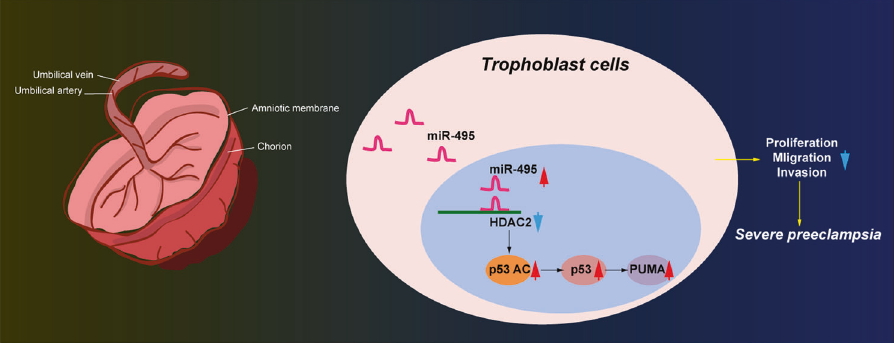
Fig. 7 Schematic diagram of the mechanism by which miR-495 suppresses the expression of HDAC2 to activate p53/PUMA axis, inhibiting proliferation, migration and invasion, but promoting apoptosis of trophoblast cells, which may lead to the development of PE. The mechanism of how miR-495/HDAC2/p53/PUMA axis functions in the pathogenesis of